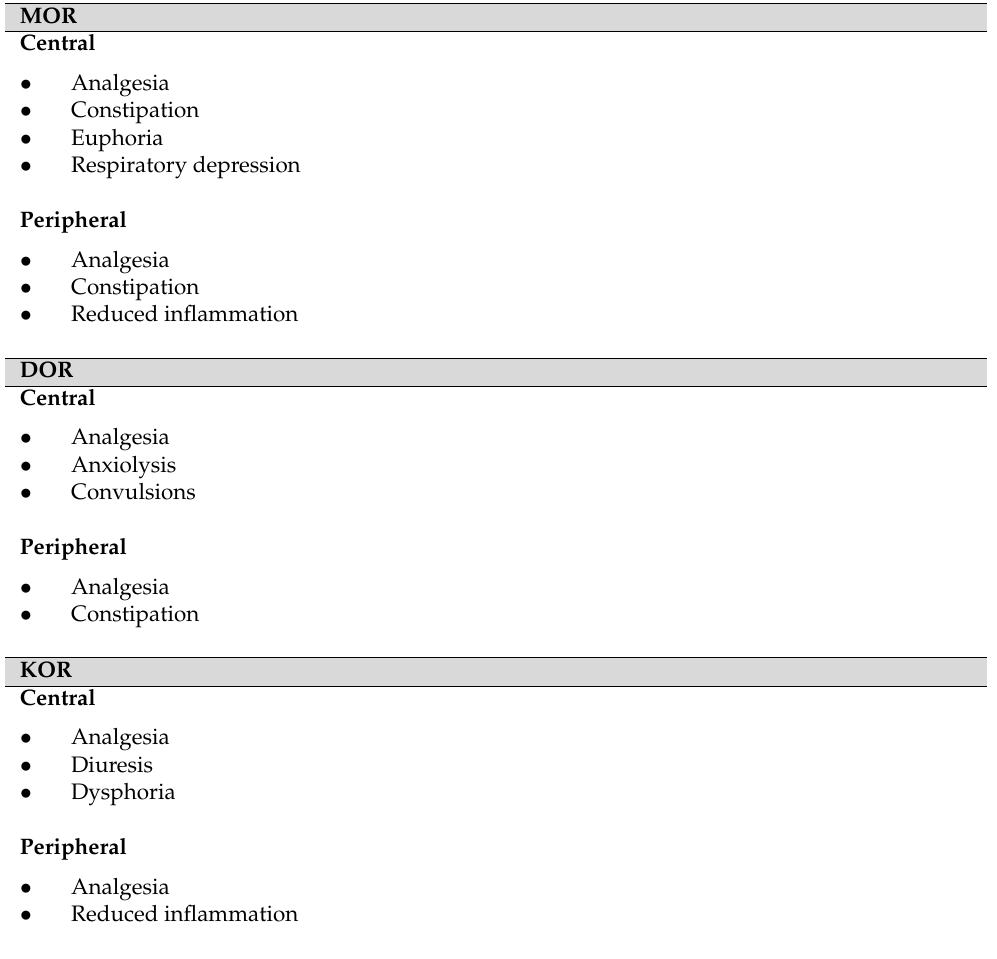
Table 1. Effects of classical opioid